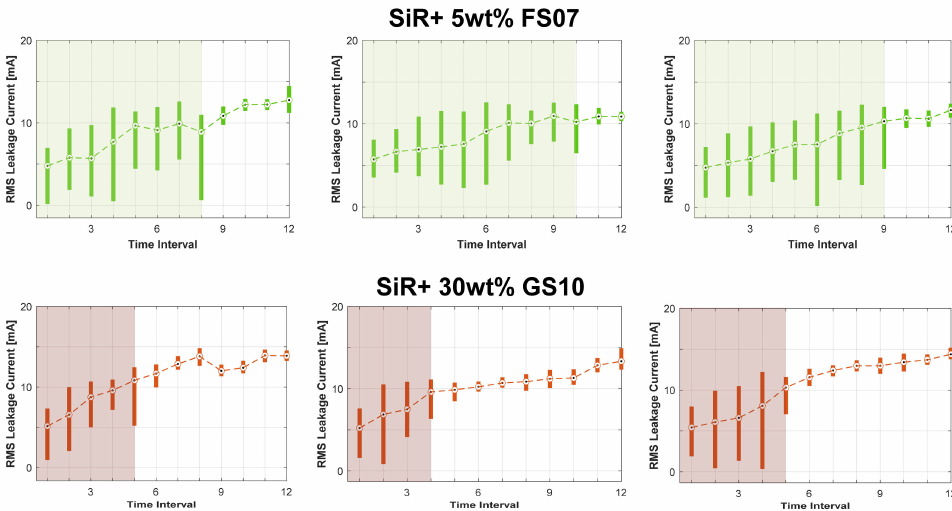
Figure 5. Statistical boxplot outcomes for selected samples of the +DC IPT tested composites during the first 12 20-min time intervals of the